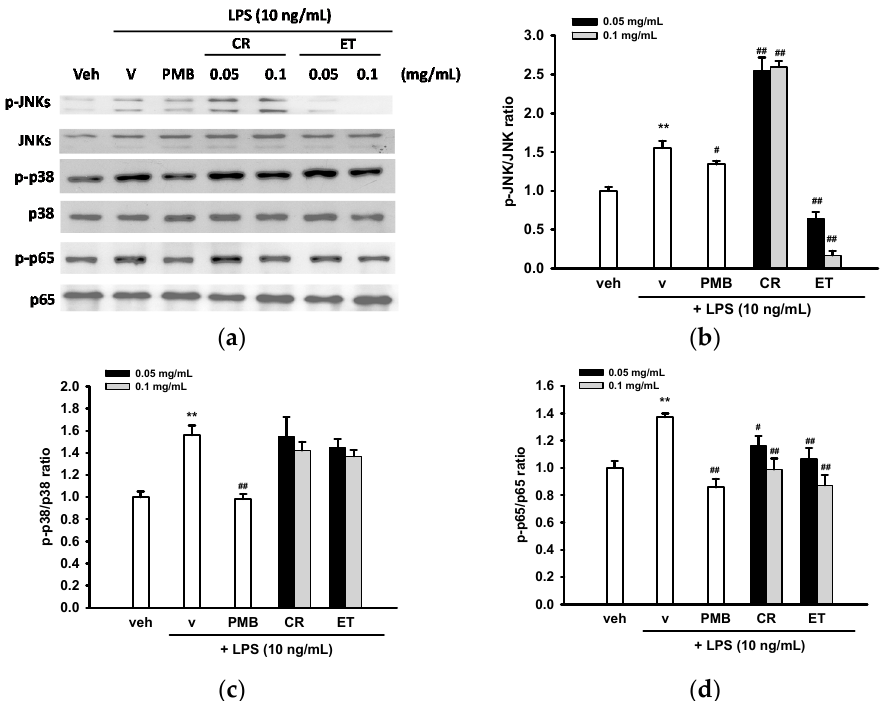
Figure 6 . Effects of ethanol extracts of C. rutidosperma (CR) and E. thymifolia (ET) on phosphorylation of JNK, p38 MAPK and p65 in BV2 cells. ( a ) BV2 cells were pre-treated with the indicated reagent for 30 min and then stimulated for 30 min with LPS (10 ng/mL). Western blots were performed using the appropriate antibodies. Representative blots from three independent experiments are shown; ( b – d ) Densitometry is presented as the mean ± SD of three independent experiments. Statistical differences are presented ** p < 0.01 compared with the vehicle control (without LPS) and # p < 0.05; ## p < 0.01 compared with the LPS-treated vehicle.